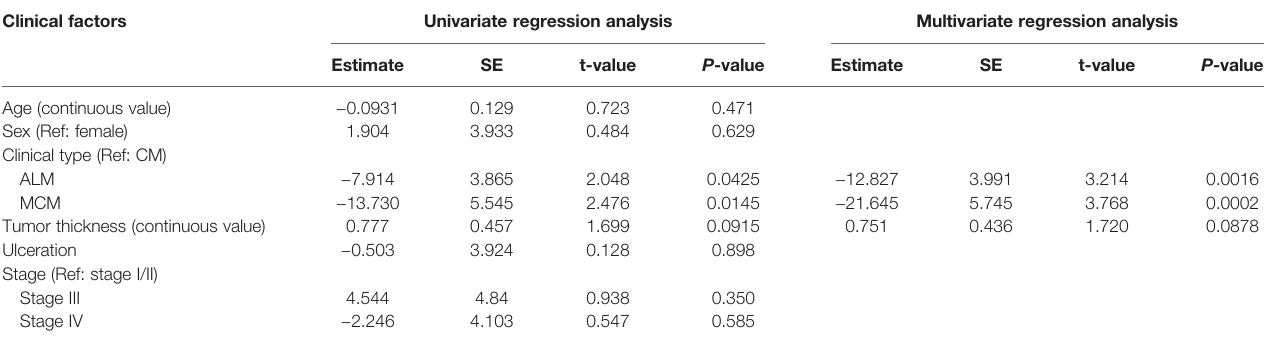
TABLE 4 | Association of CD8 + TIL number with clinical factors. Clinical factors